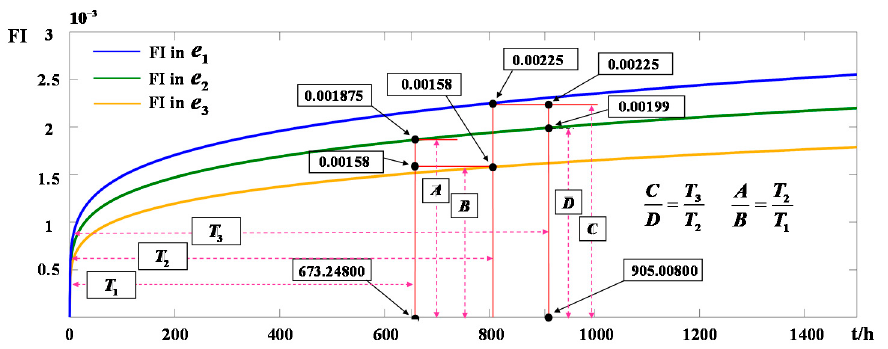
Figure 3. The results of FIs in three WCs. e e e Comparing the FIs in 1 and 2 , it can be seen that the FI in 1 is always greater e e than that in 2 , which means that the combined effect of each factor in 1 is more likely e to cause failure than that in 2 . By using Equation (10), it can be discerned that the unit e e time damage in 1 is 1.13 times the unit time damage in 2 . Based on this, the relation- e is equal to 1 e . Equal cumulative damage does not 2